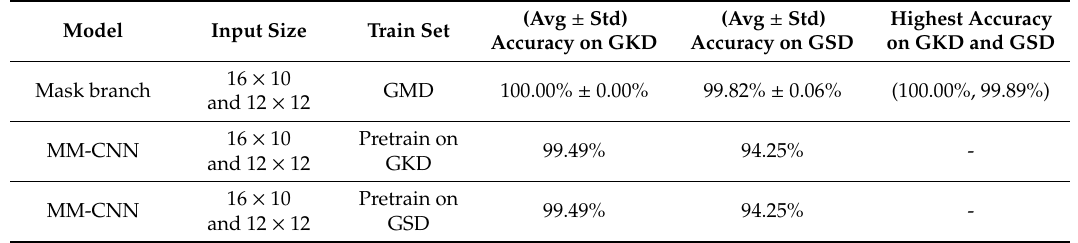
Figure 5. T-distributed stochastic neighbor embedding analysis of embedding after global pooling in mask branch. Table 5. Overall results of MM-CNN trained on grasping merged dataset (GMD).